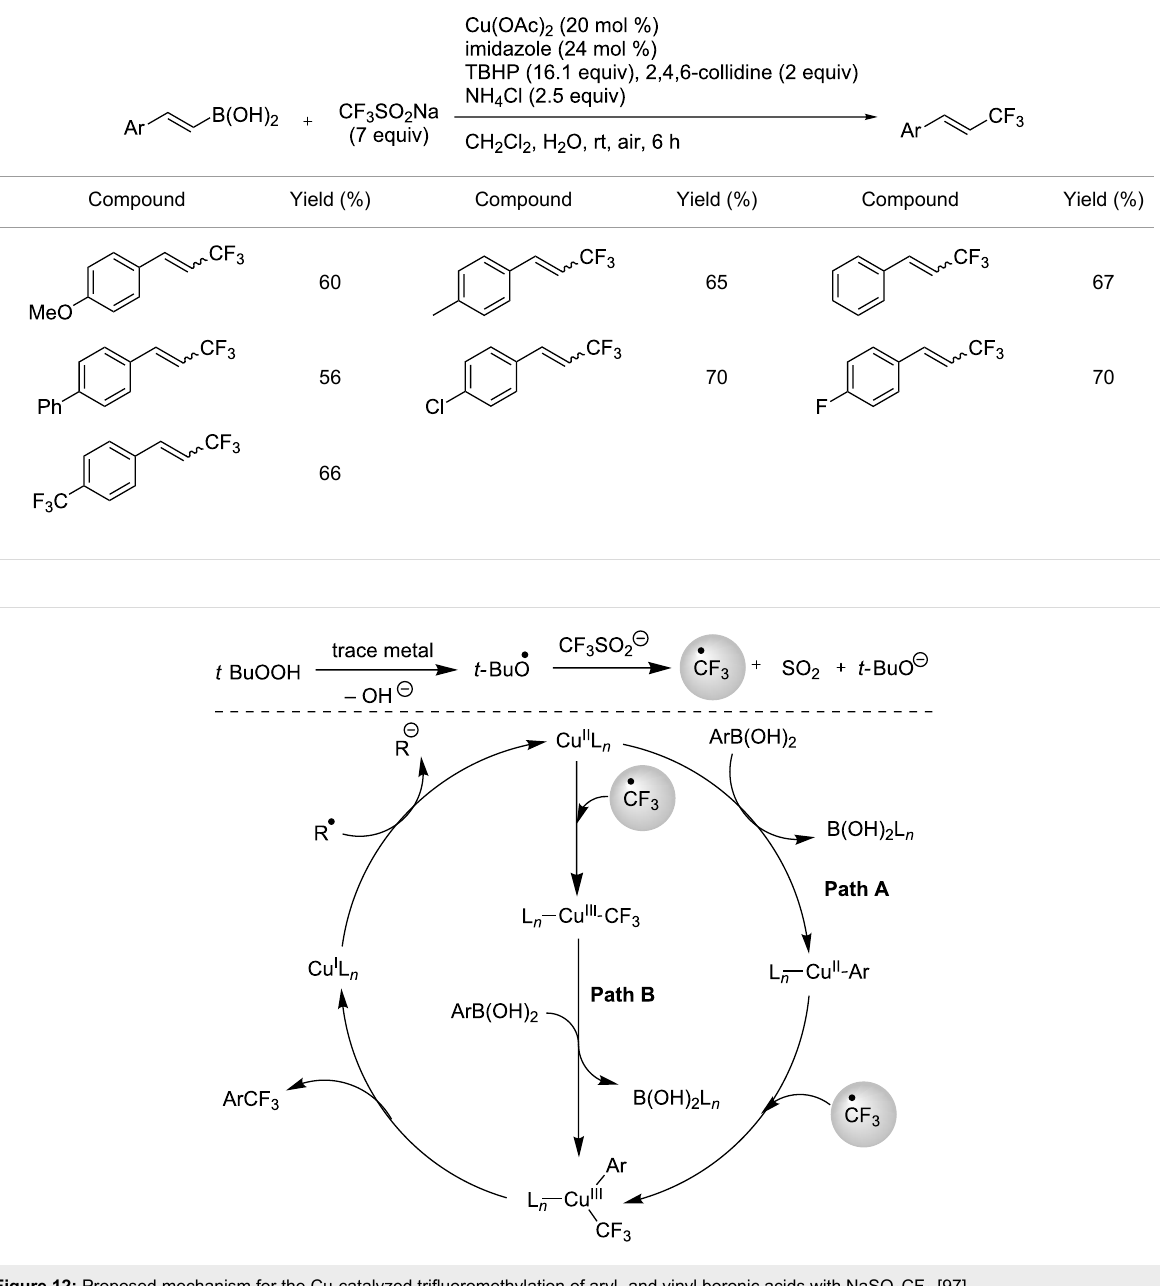
Figure 12: Proposed mechanism for the Cu-catalyzed trifluoromethylation of aryl- and vinyl boronic acids with NaSO 2 CF 3 [97].